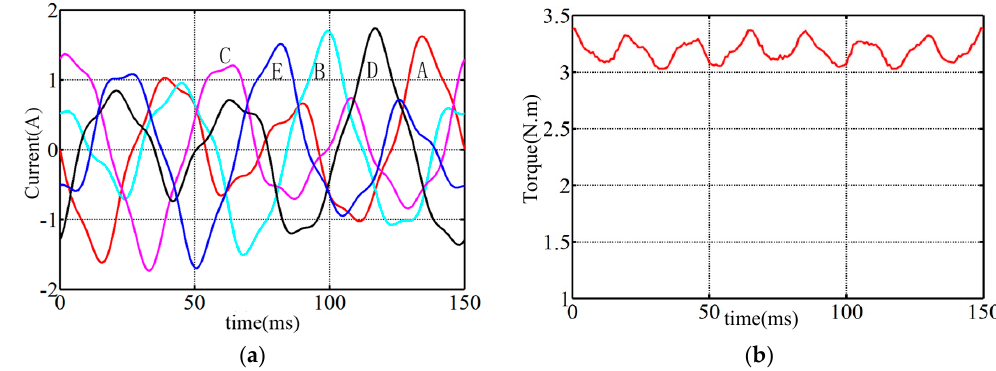
Figure 14. The current and torque simulation of series − connected SIN − FPMSM with i cmp : ( a ) five − phase current; ( b ) torque.